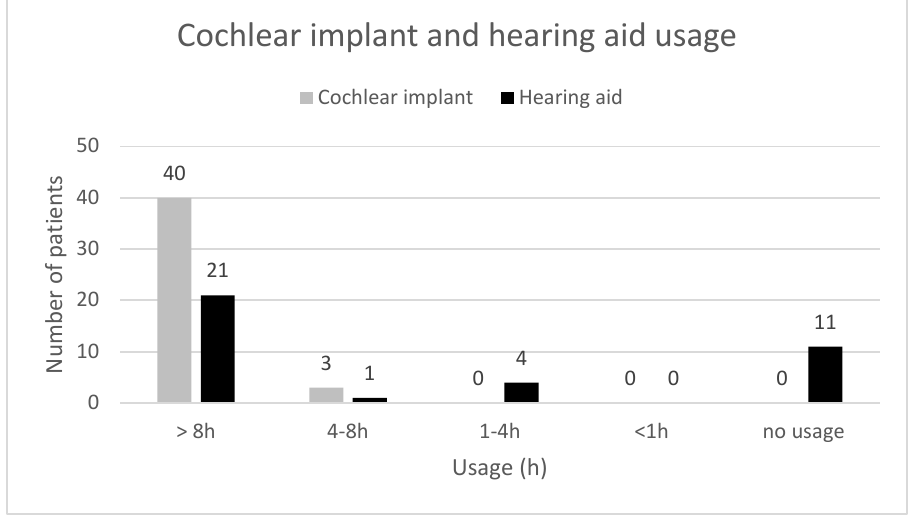
Figure 4. Cochlear implant and hearing aid usage.